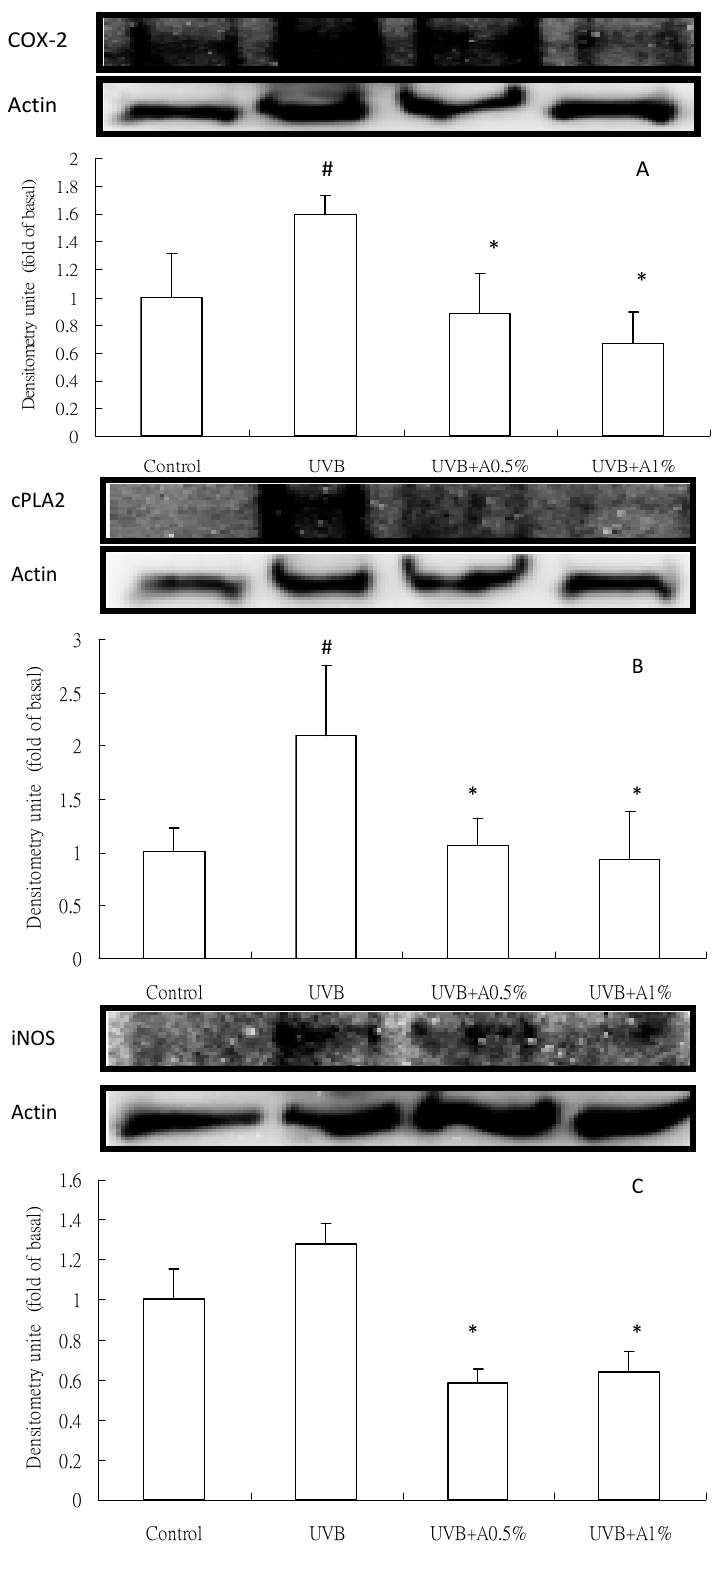
Figure 5. Inflammatory protein expression of skin tissue on UVB-irradiated skin damage in hairless mice: ( A ) cPLA2; ( B ) COX-2; ( C ) iNOS and VCAM-1. # p < 0.05 vs. control group; * p < 0.05 vs. UVB-irradiated